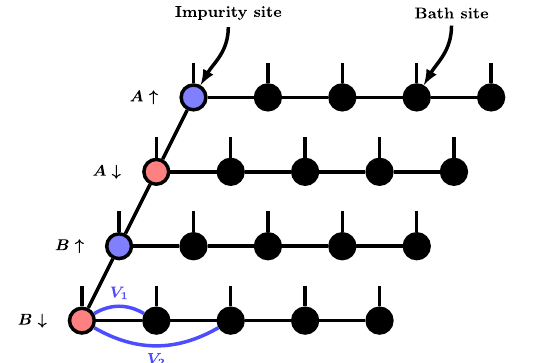
FIG. 2. Graphical representation of a FTPS for multi-orbital AIM. Separating bath degrees of freedom leads to a forklike structure. In this picture, a two-orbital model is shown, with four bath sites in each orbital. Orbitals are labeled A and B , and the arrows denote the spin. Each spin-orbital combination has its own bath sticking out to the right. As in Fig. 1, the vertical lines are the physical degrees of freedom [all of dimension two, for empty (respectively, occupied) bath sites]. All other lines are bond indices, and like in the MPS, they are summed over. As mentioned in the text, the bath is represented in star geometry because of the smaller bond dimensions needed. The bath sites are ordered according to their on-site energies. Two example hoppings V 1 and V 2 are